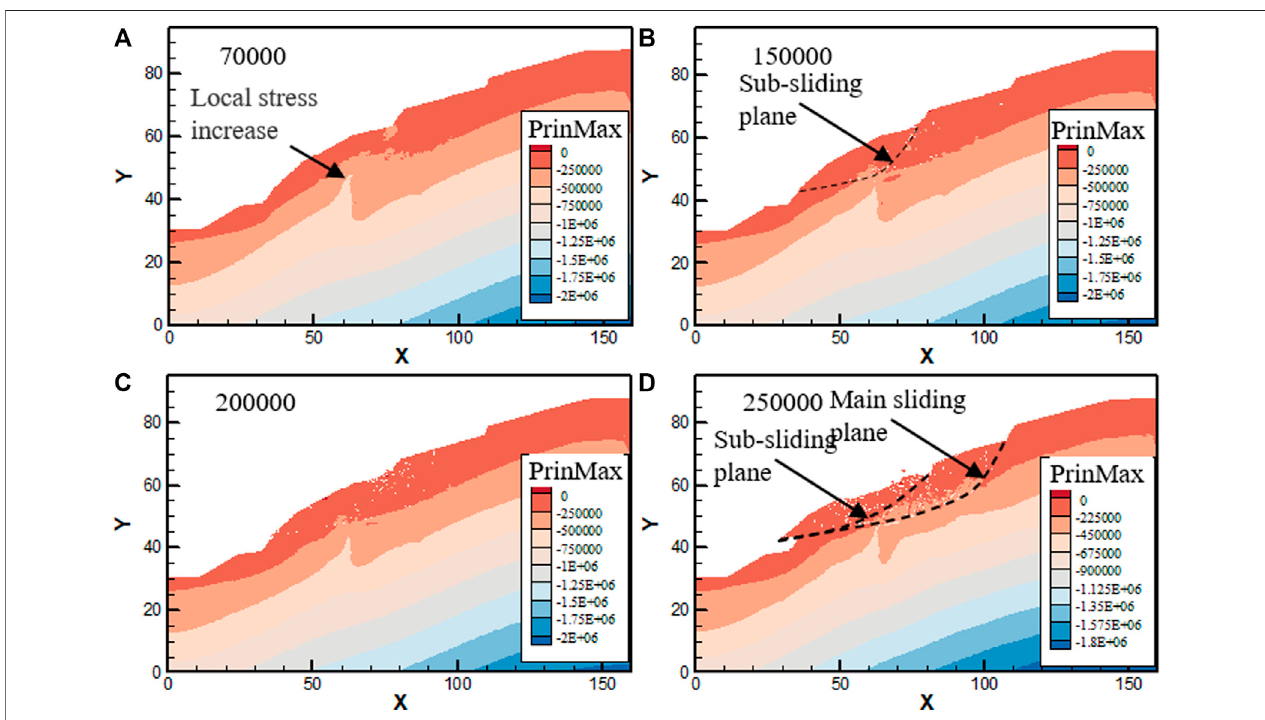
FIGURE 5 | Maximum principal stress nephoram (unit:Pa). (A) : t = 70,000 steps, (B) : t = 1,50,000 steps, (C) : t = 2,00,000 steps, (D) : t = 2,50,000 steps.